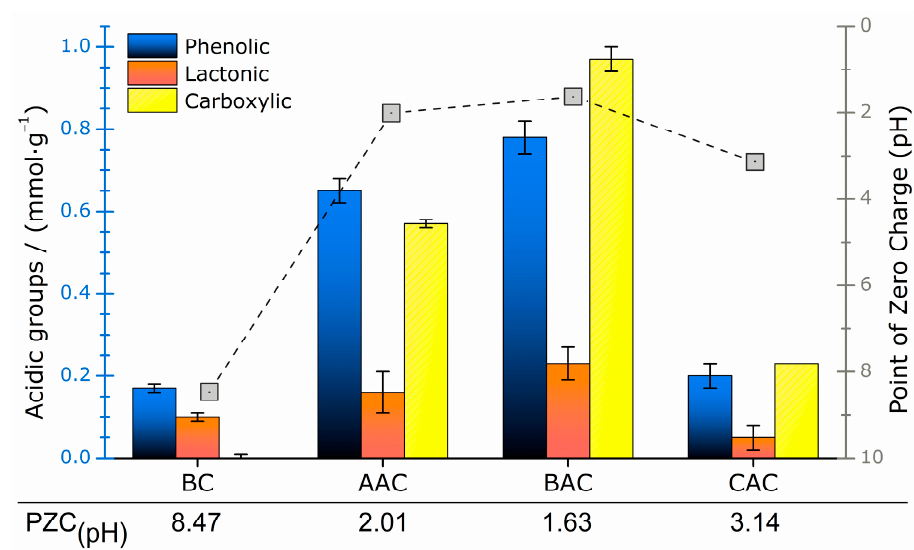
Figure 2. Boehm titration and PZC.